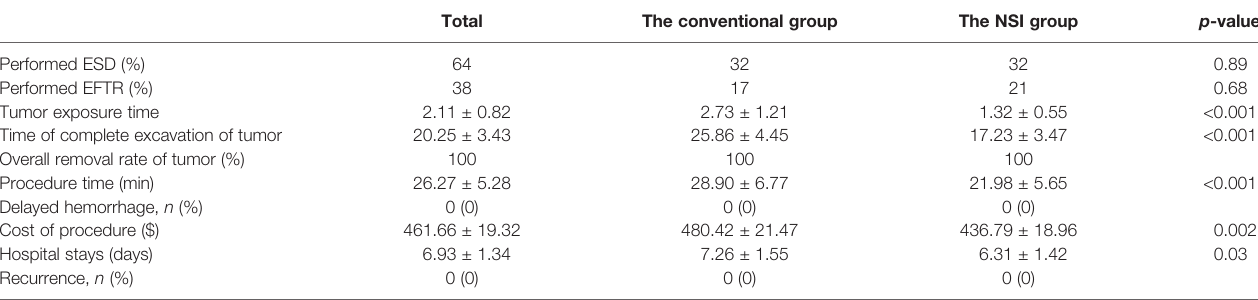
TABLE 2 | Outcomes of ER.